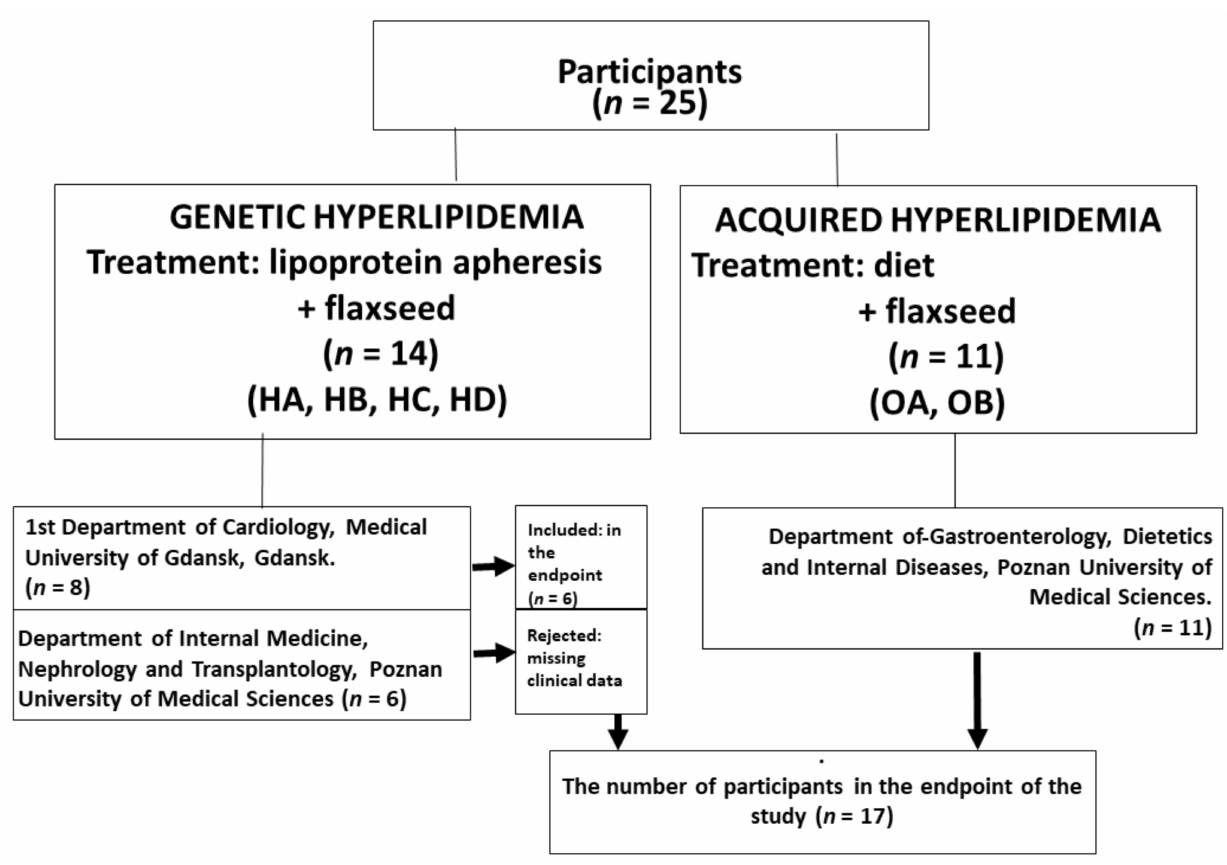
Figure 1. Diagram of the study. Abbreviation: HA—ordinary diet; HB—ordinary diet +